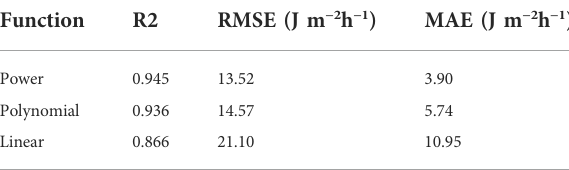
TABLE 3 Statistical analysis of the relationship between KE exp and I r . Function